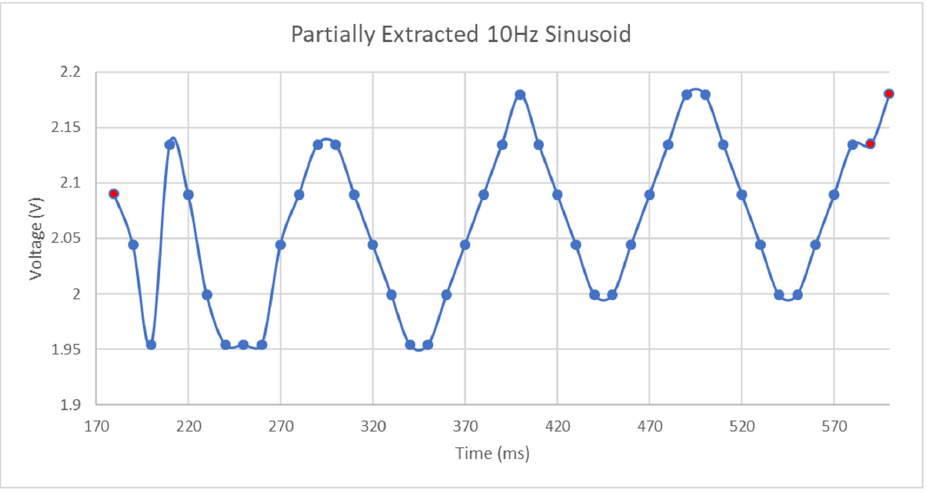
Figure 20. 10 Hz partially extracted Figure 20. 10Hz partially extracted sinusoid.